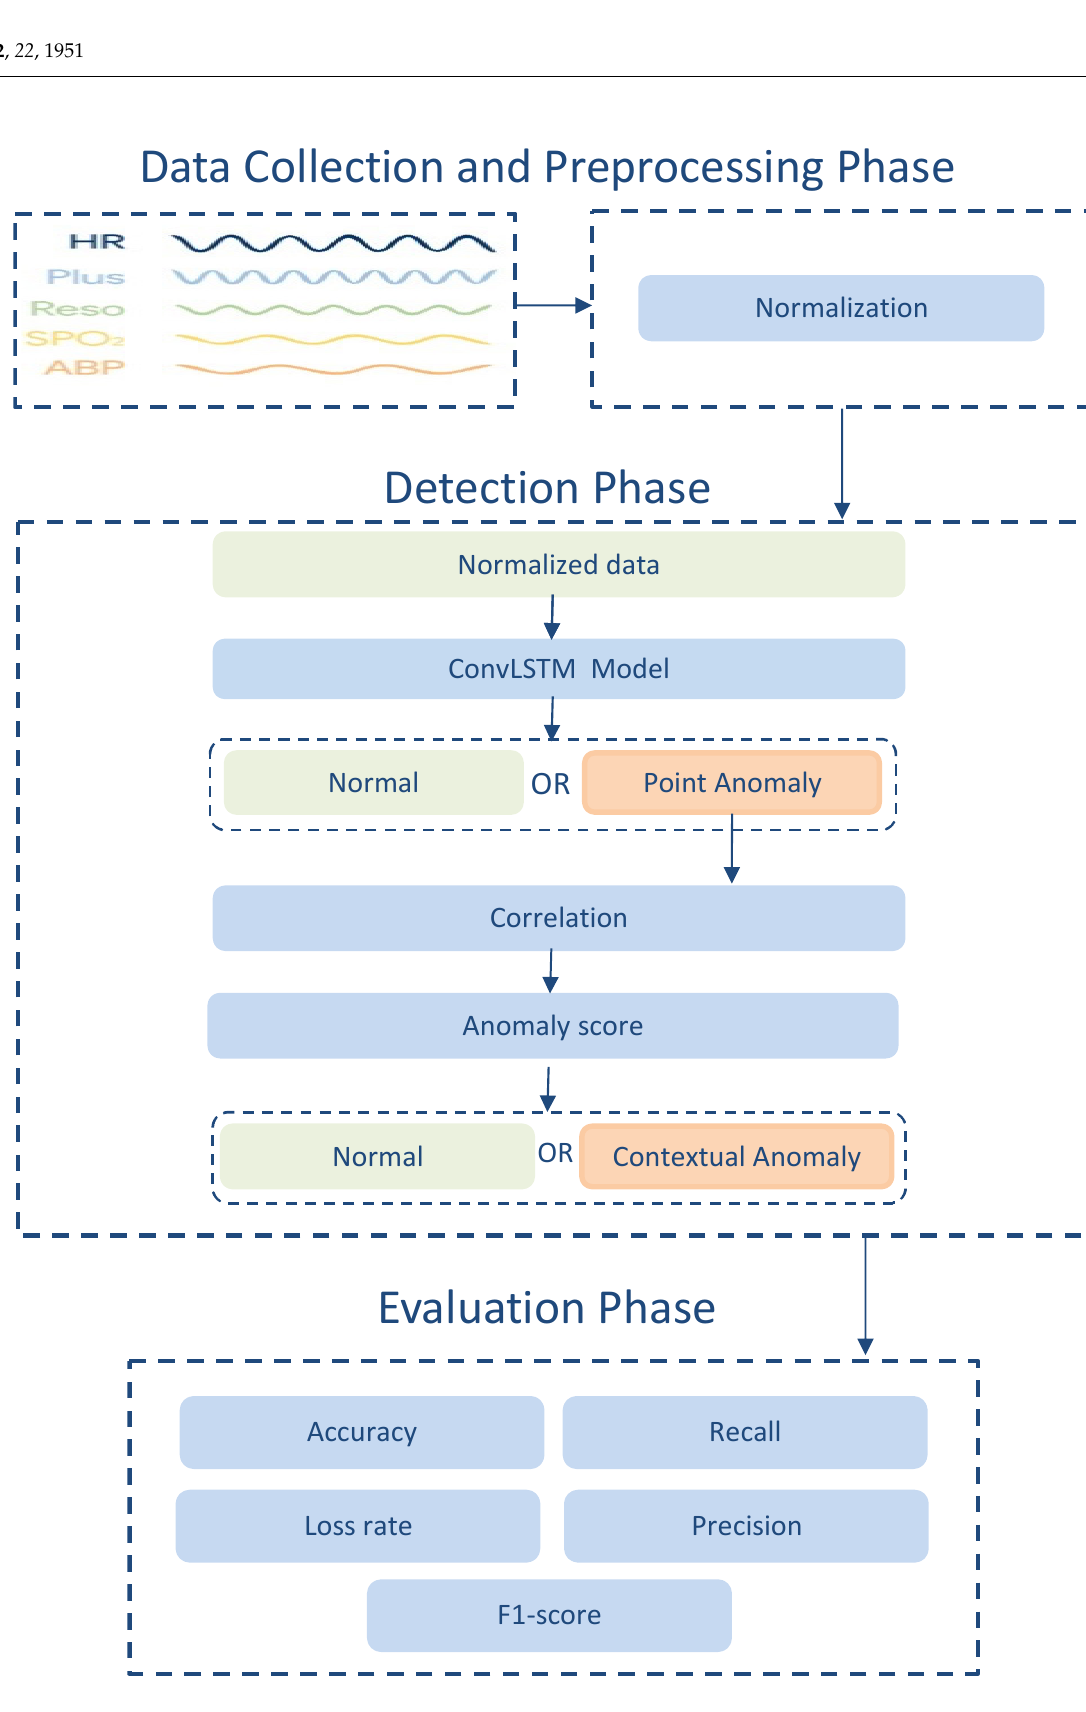
Figure 1. Proposed Mode.